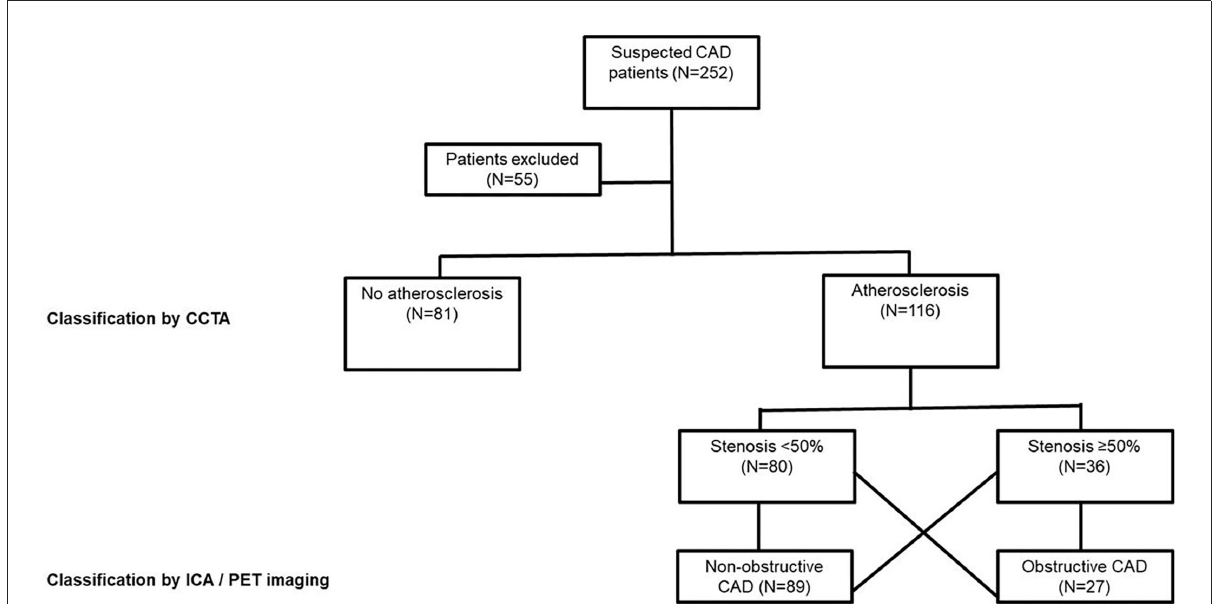
FIGURE1 Study population. Obstructive CAD is defined as a coronary atherosclerosis associated with an abnormal stress myocardial blood flow (MBF) on a CCTA or > 70% coronary stenosis on an ICA . N, number of individuals; CAD, coronary artery disease; CCTA, coronary computed tomography angiography (CCTA); PET, positron emission tomography; ICA, invasive coronary